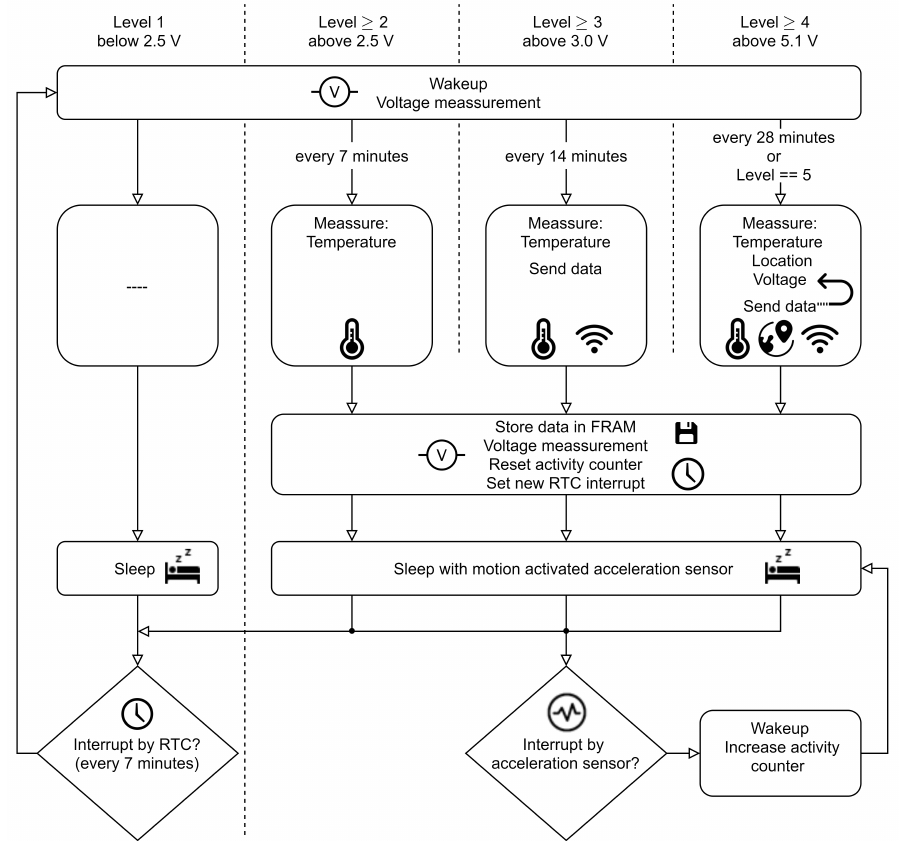
Figure 8. Flowchart of the algorithm. Most of the time, the tracker is put into sleep and only wakes up after a period of seven minutes, checks the voltage, and fulfills the task according to a defined time and voltage